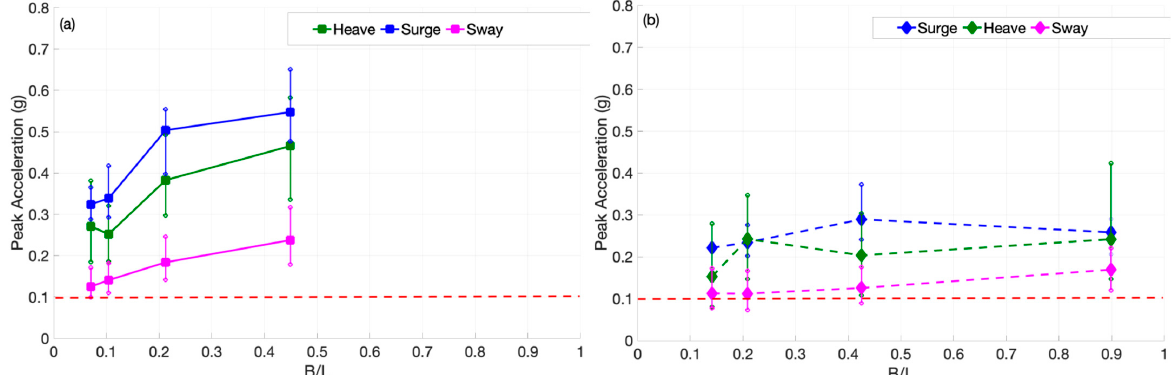
Figure 7. Peak in Single (Surge, Heave and Sway) Axis of Acceleration Plotted Against Beam-to- wavelength Ratio and Compared Against the Safe Motion Limit of 0.1g. ( a ) Narrow Pontoon and ( b ) Wide Pontoon. Range between 5 sensors and 3 test repetitions shown by vertical lines and solid symbol being the average of the 15 results.